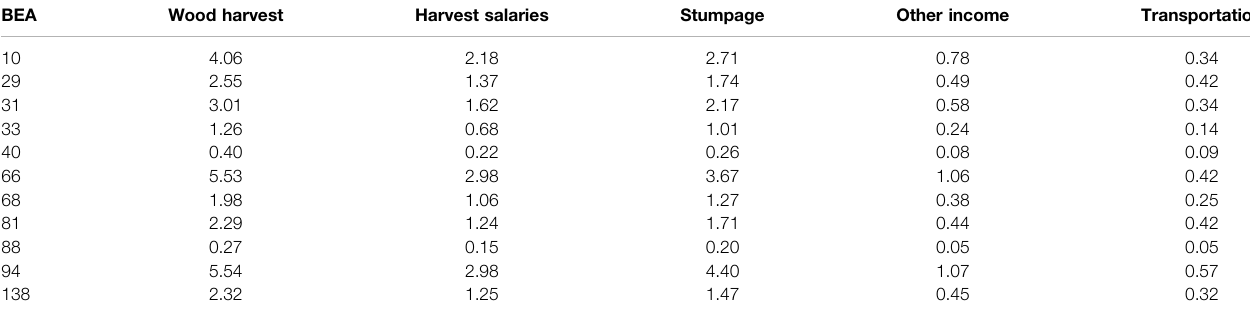
TABLE 10 | Factors used to estimate the economic impact from feedstock harvest and delivery to the biore fi neries by BEA. BEA Wood